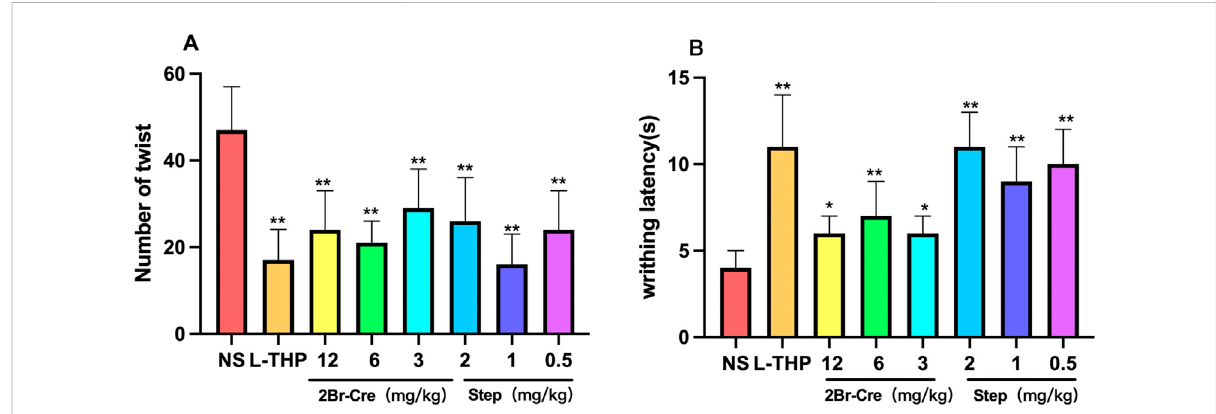
FIGURE 4 In vivo analgesic test results for 2Br-Cre and Step in Writhing test, (A) The effects of 2Br-Cre (12, 6, and 3 mg/kg) and Step (2, 1, and 0.5 mg/kg) on the number of acetic acid-inducedwrithing movements inmice. (B) The effects of 2Br-Cre (12, 6, and 3 mg/kg) and Step (2, 1,and 0.5 mg/kg) on acetic acid-induced fi rst writhing latency in mice; Data are expressed as mean ± SD. * p < 0.05, ** p < 0.01 versus NS group using one-way ANOVA followed by S-N-K ’ s post hoc multiple-comparison test.